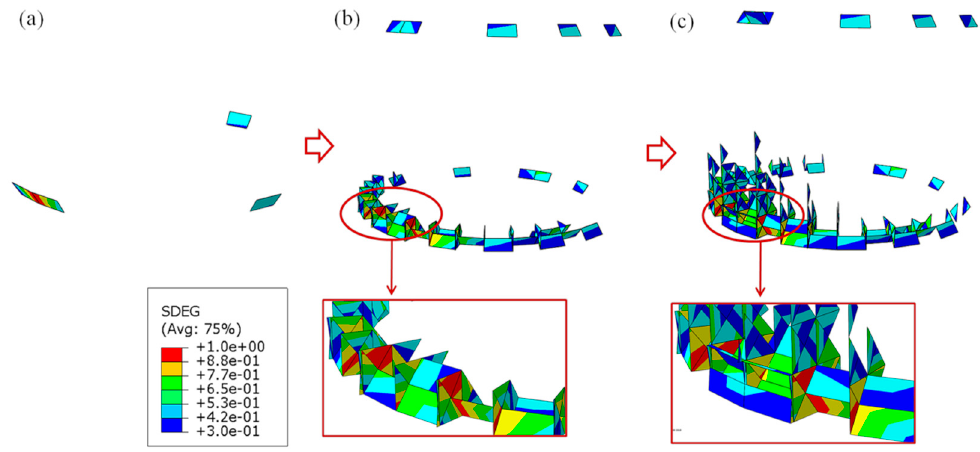
Figure 15. Fatigue damage progress of the SMATed specimen under 9796 N.